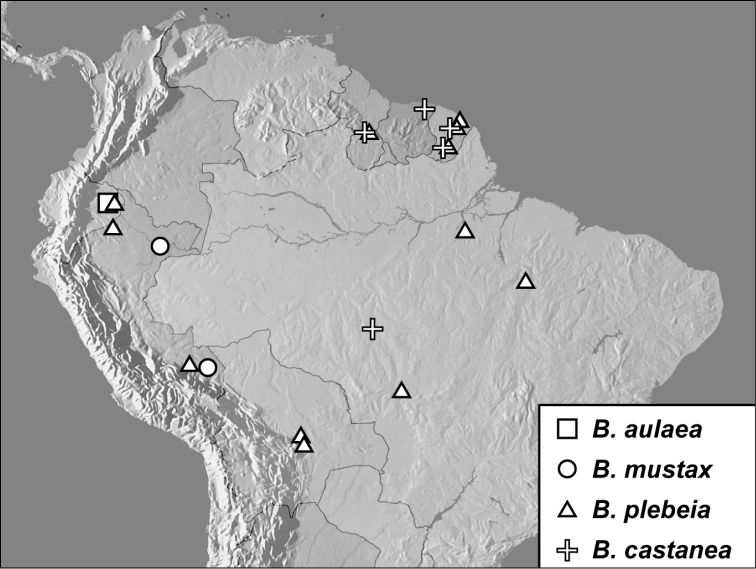
Baconia aeneomicans group records.